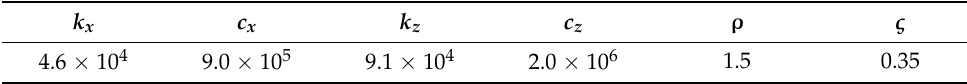
Table 2. Main parameters of the contact